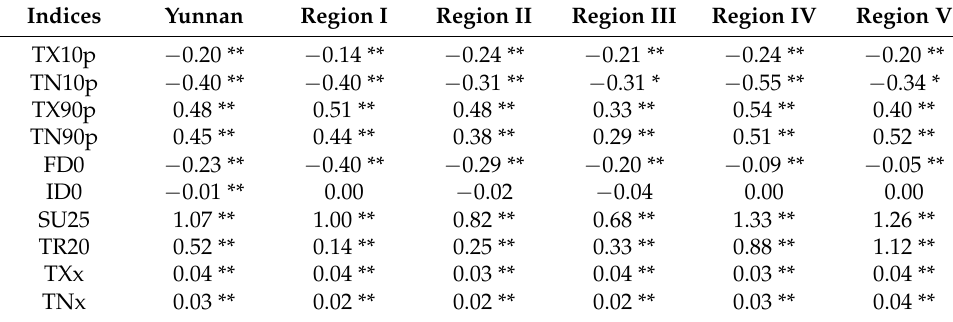
Figure 2. Changes of annual extreme temperature indices in Yunnan during 1960−2019. Notes: The annual values of these extreme temperature indices are calculated by averaging 120 weather stations for the same year. Table 2. Trends of extreme climate changes in different subregions of Yunnan during 1960–2019.